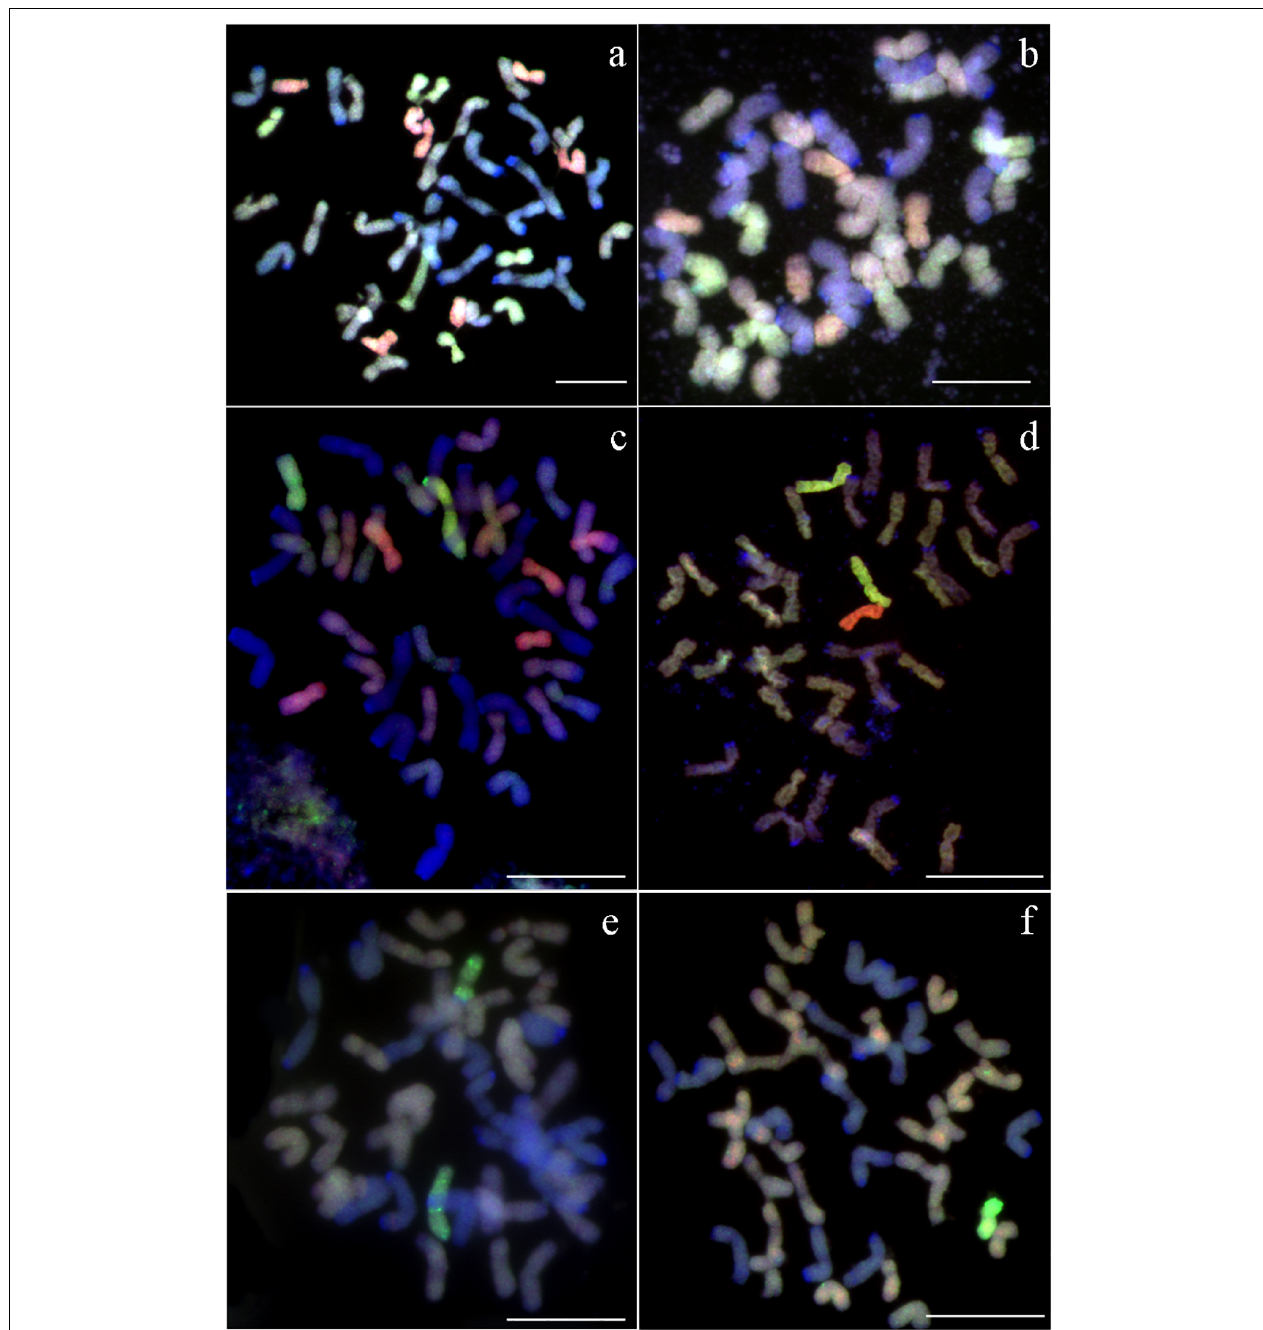
FIGURE 5 | Genomic in situ hybridization performed on mitotic chromosomes of (a) F 1 , (b) BC 1 F 1 , (c) BC 2 F 1 , (d) BC 3 F 1 , (e) BC 4 F 1 , and (f) BC 5 F 1 triticale- Aegilops introgression plants. A- and B-genome chromosomes are labeled with DAPI (light blue), as well as R-genome chromosomes (dark blue). U k - and S k -genome chromosomes are labeled with Atto-550 (red) and Atto-488 (green), respectively. Scale bar, 10 µ